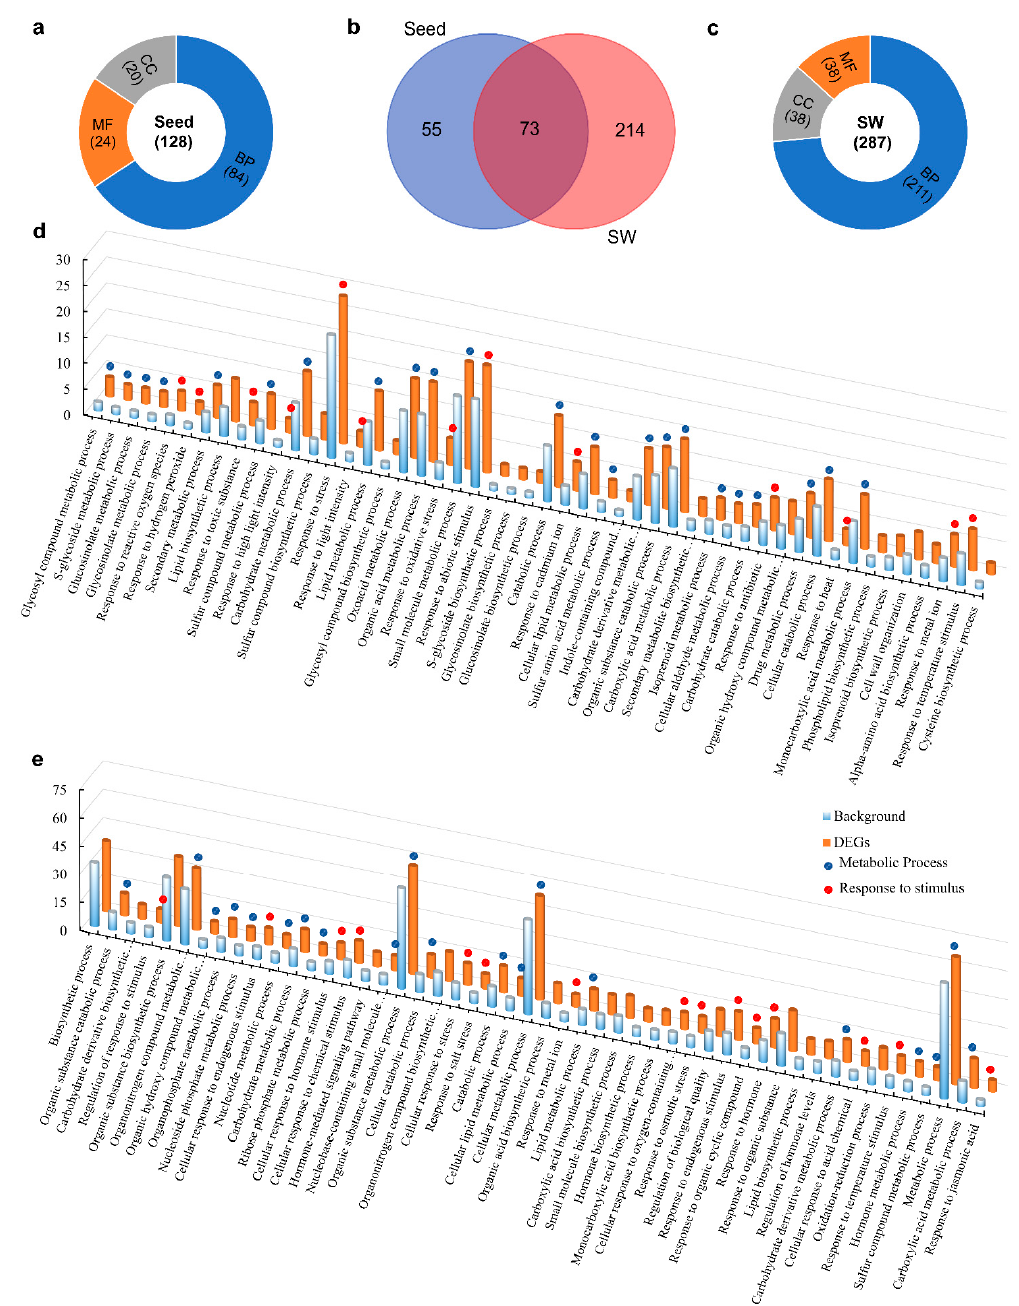
Figure 8. Gene Ontology (GO) enrichment analysis of seed and SW DEGs. ( a ) A number of GO terms in each category enriched by seed DEGs. ( b ) GO terms uniquely enriched by seed or SW DEGs and commonly enriched terms by both tissues. ( c ) A number of GO terms in each category (BP, MF, and CC) enriched by seed DEGs. ( d ) Top 50 GO terms included in the biological process category in seed DEGs ( e ) Top 50 GO terms included in the biological process category in SW DEGs. The y-axis is the percentage of genes mapped by the term, representing the abundance of the GO term. Percentages for the input list were calculated by the number of genes mapped to the GO term divided by the number of all genes in the input list; the same calculation was applied to the reference list (background). BP, biological process; MF, molecular function; CC, cellular component.